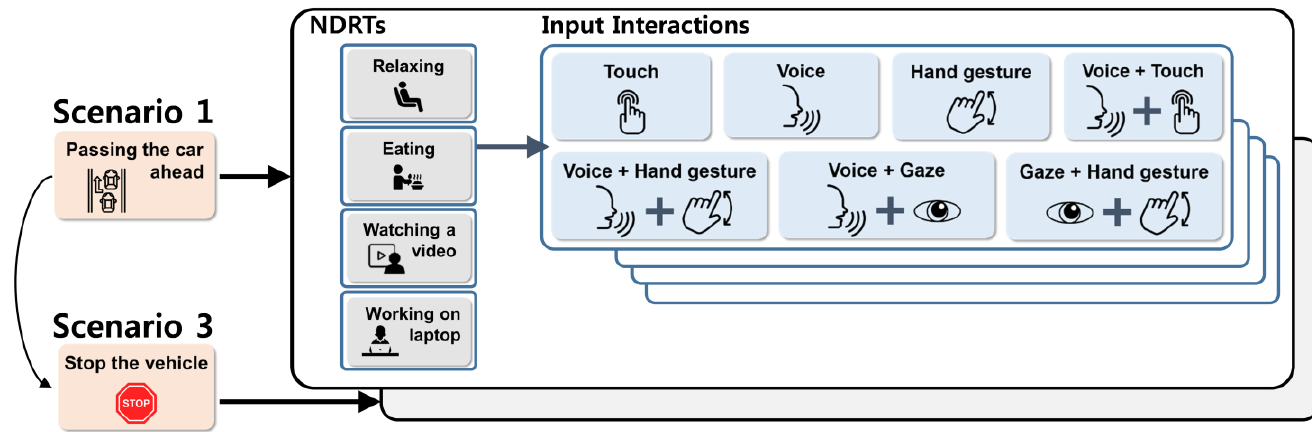
Figure 3. Diagram of our survey implementation; two pairs of the scenario were provided per each participant with a counterbalanced design.